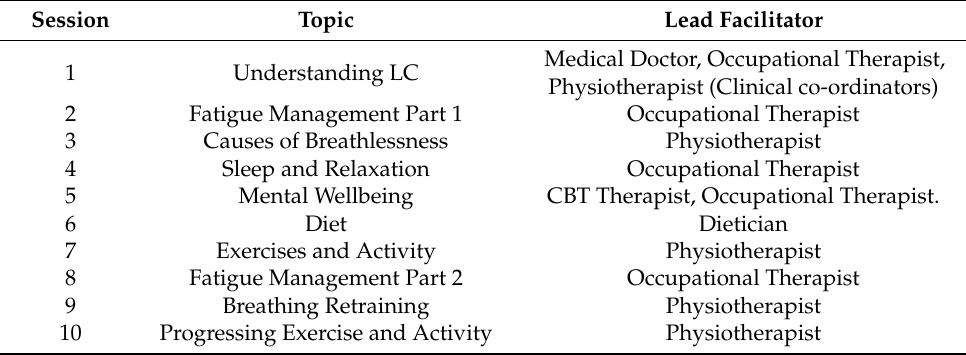
Table 1. Sessions from Virtual Course for Symptom Management of Long